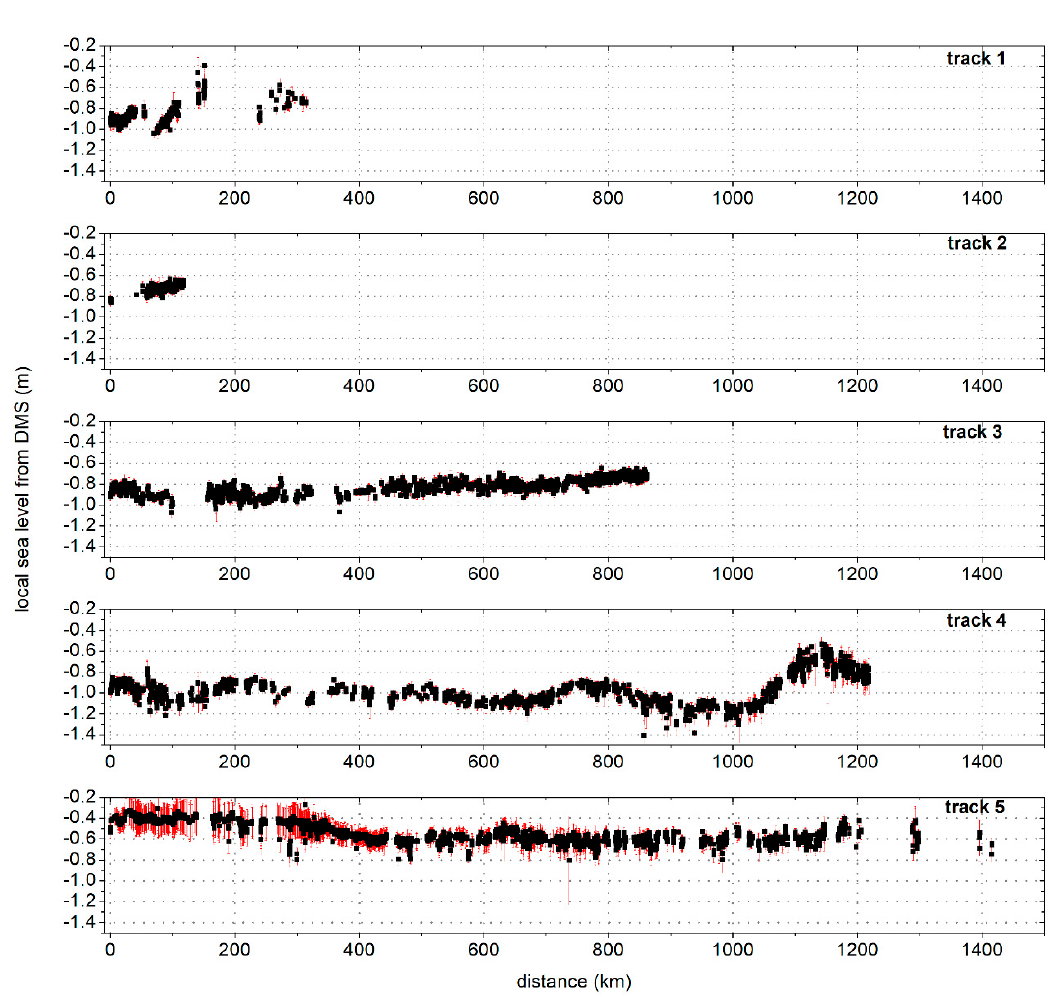
Figure 2. Local sea level with ± 1 standard deviation (red) for each track by using the Digital Mapping System’s (DMS) lead detection. The direction in which the along-track distance is measured (start and end) is indicated with the arrows in Figure 1 (adapted from [21]).